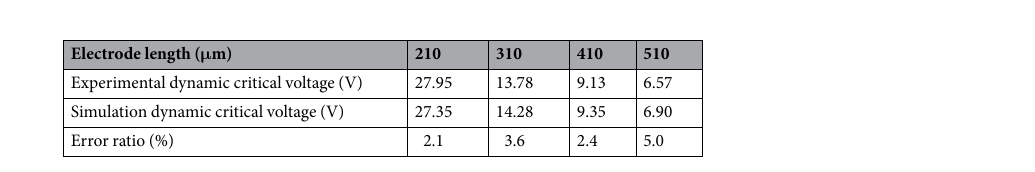
Table 3. Comparison of the sensor voltage with experimental dynamic responses 58